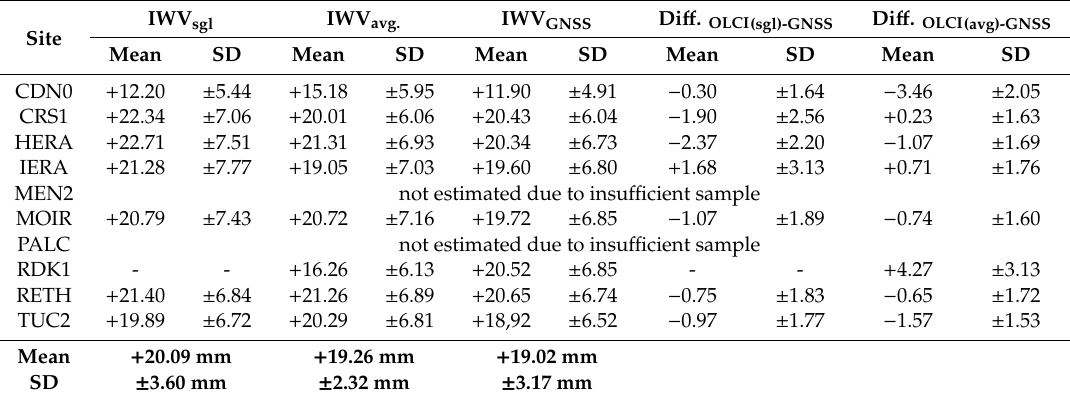
Table 5. The mean and standard deviation (SD) for the IWI derived from Sentinel-3B OLCI, and GNSS as well as for their differences at the GNSS stations. All values are in [mm]. The overall mean and SD per IWV determination approach are also given in bold.